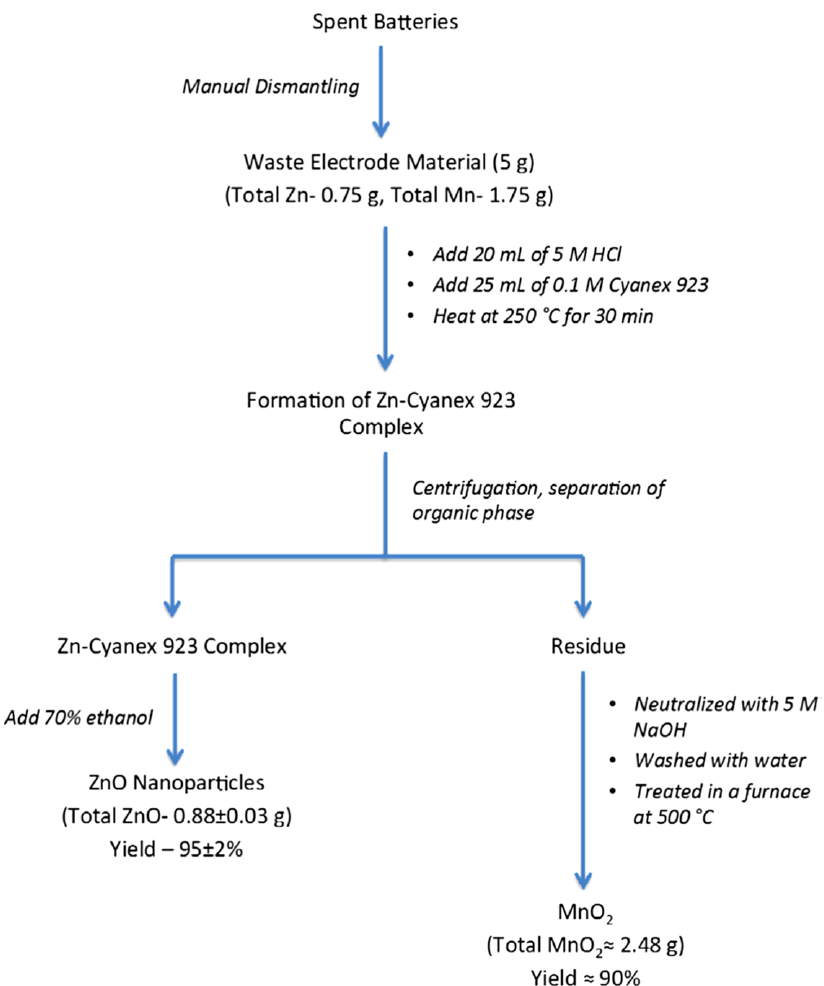
Figure 11. The processing flowchart regarding the recycling of the electrode waste of spent alkaline Zn-MnO 2 batteries to produce high-purity ZnO NPs [40].